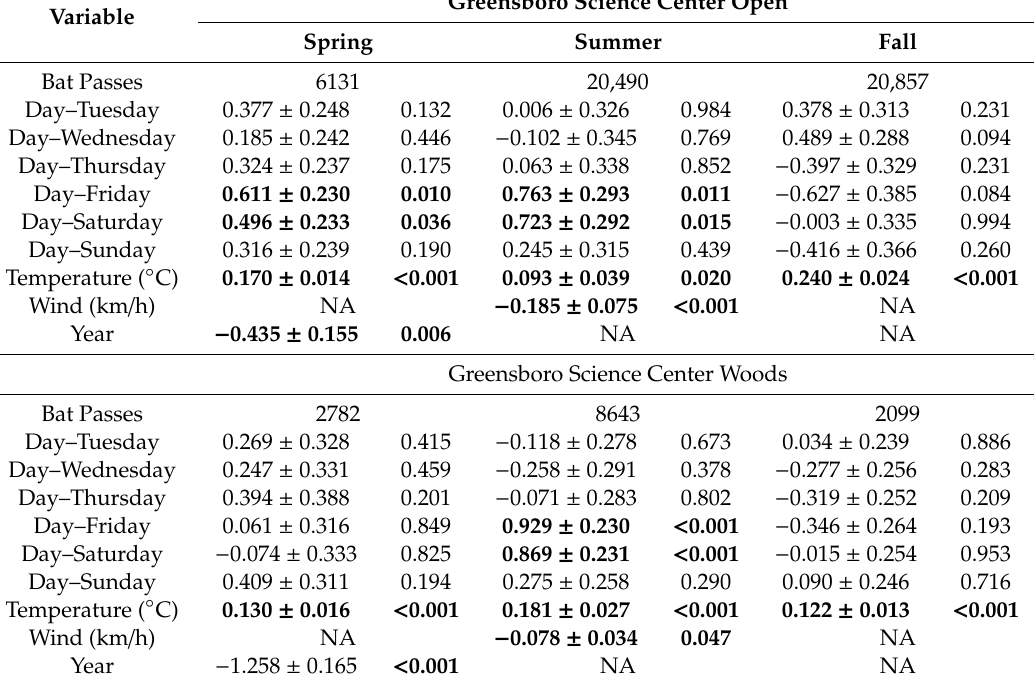
Table 1. Numbers of total bat passes (including no species identification) collected in 2018 and 2019 springs, summers, falls and generalized linear model results (total bat passes versus day of the week and environmental covariates, regression estimate ± standard error and p value reported) by season at the Greensboro Science Center sites in Greensboro, North Carolina, USA. “NA” indicates variables dropped from the final model. Bold numbers indicate significant results.